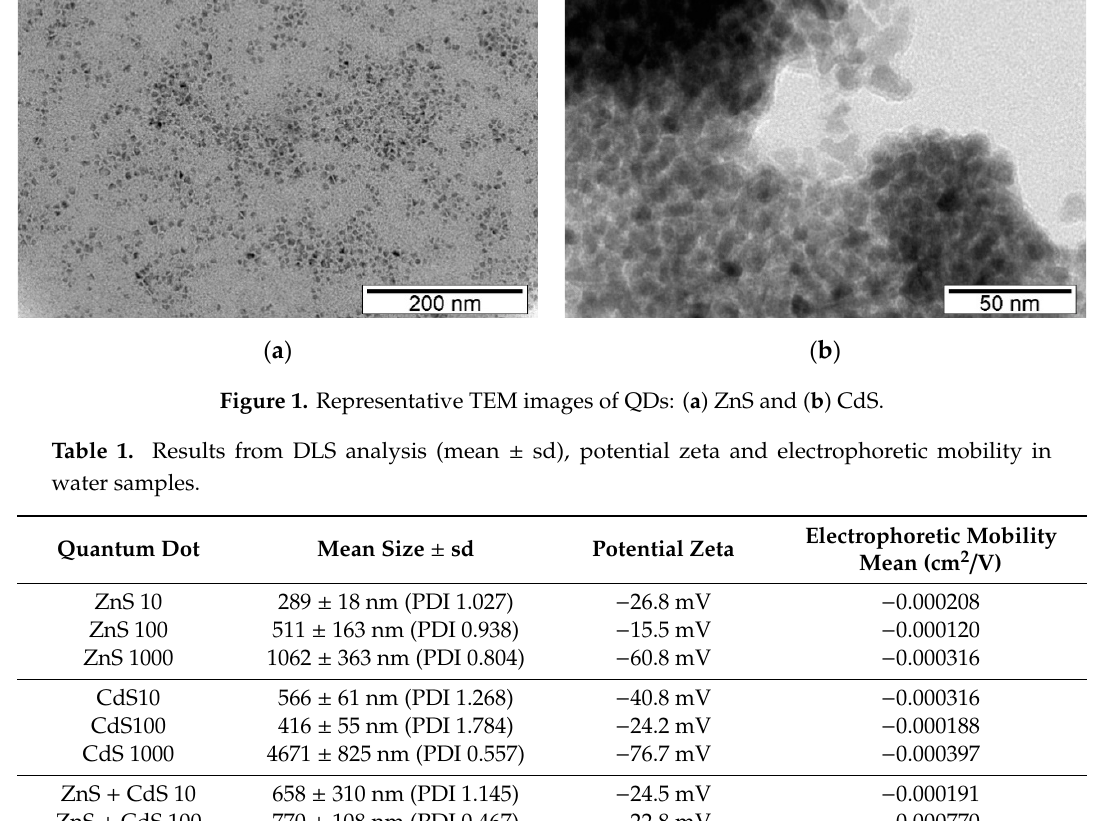
Table 1. results from DLS analysis (mean ± sd), potential zeta and electrophoretic mobility in water samples.